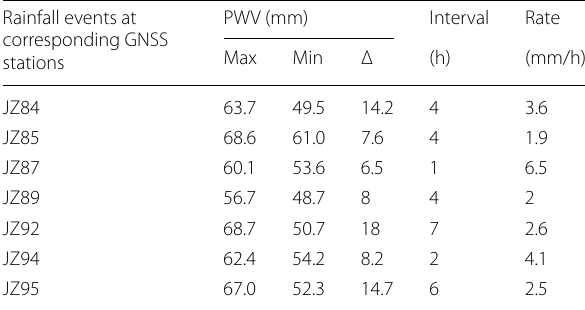
Fig. 8 Temporal evolution of PWV retrieved at 11 GNSS stations from 27 June to 6 July